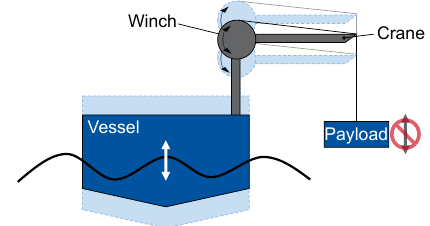
Figure 1: Visual representation of AHC (Wll et al.,